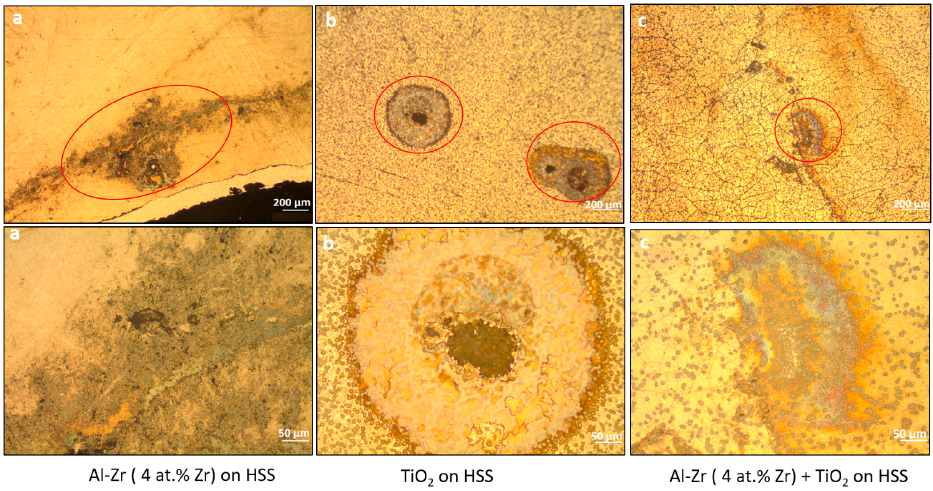
Figure 11. Optical micrographs of pits formed on ( a ) Al–Zr (4 at.% Zr), ( b ) TiO 2 , and ( c ) TiO 2 /Al–Zr bilayer films deposited on HSS after 1h of immersion in 5 wt.% NaCl.